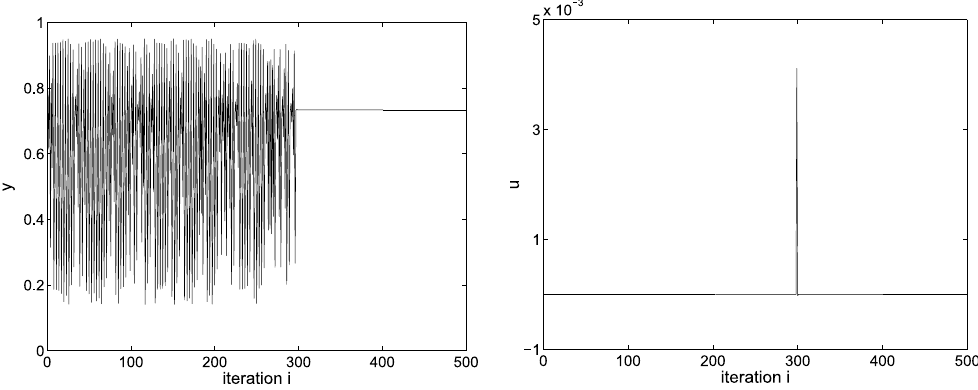
Fig. 6. Robustness of the proposed control method. (a) Behavior of y ( i ) . (b) Control input u ( i ) .